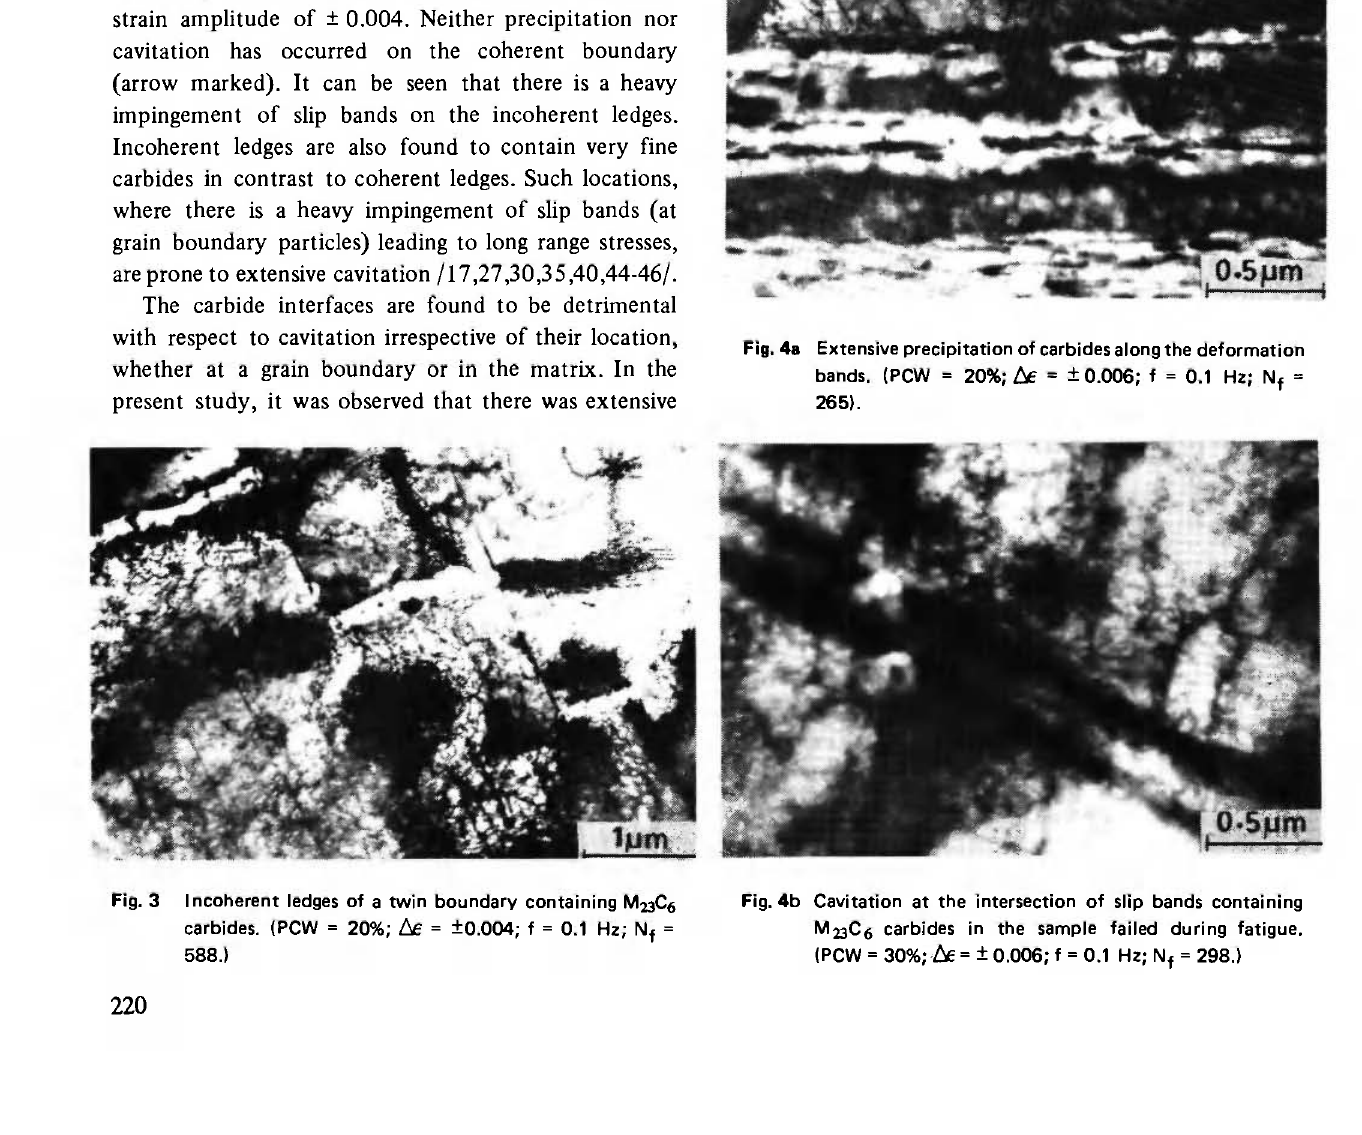
Fig. 2 Grain boundary showing precipitation of MjjCg carbides. Note that boundary had migrated leaving behind the carbides in the grain where recovery has taken place. (PCW = 20 %;Δε = ±0.0025; N f = 2,310.)